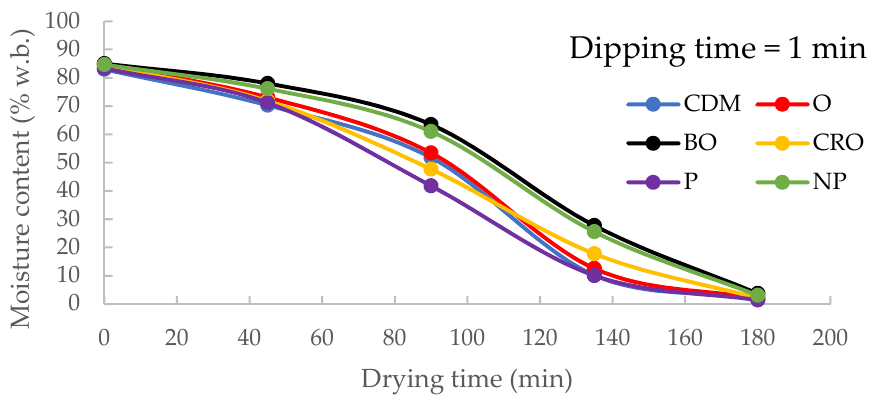
Figure 3. Effect of 1 min dipping time on drying time of different pre-treatments (tangerine ( Citrus deliciosa Mediterranean) (CDM); orange (O); bitter orange (BO); tangerine ( Citrus reticulate Owari ) (CRO); pomegranate (P); non-pre-treatment (NP)). The shortest drying time was 123 and 121 min for P pre-treated samples for 3 and 5 min dipping time, respectively (Figures 4 and 5). It reached to 164 min for CRO and 160 min for O pre-treated samples at same dipping times.